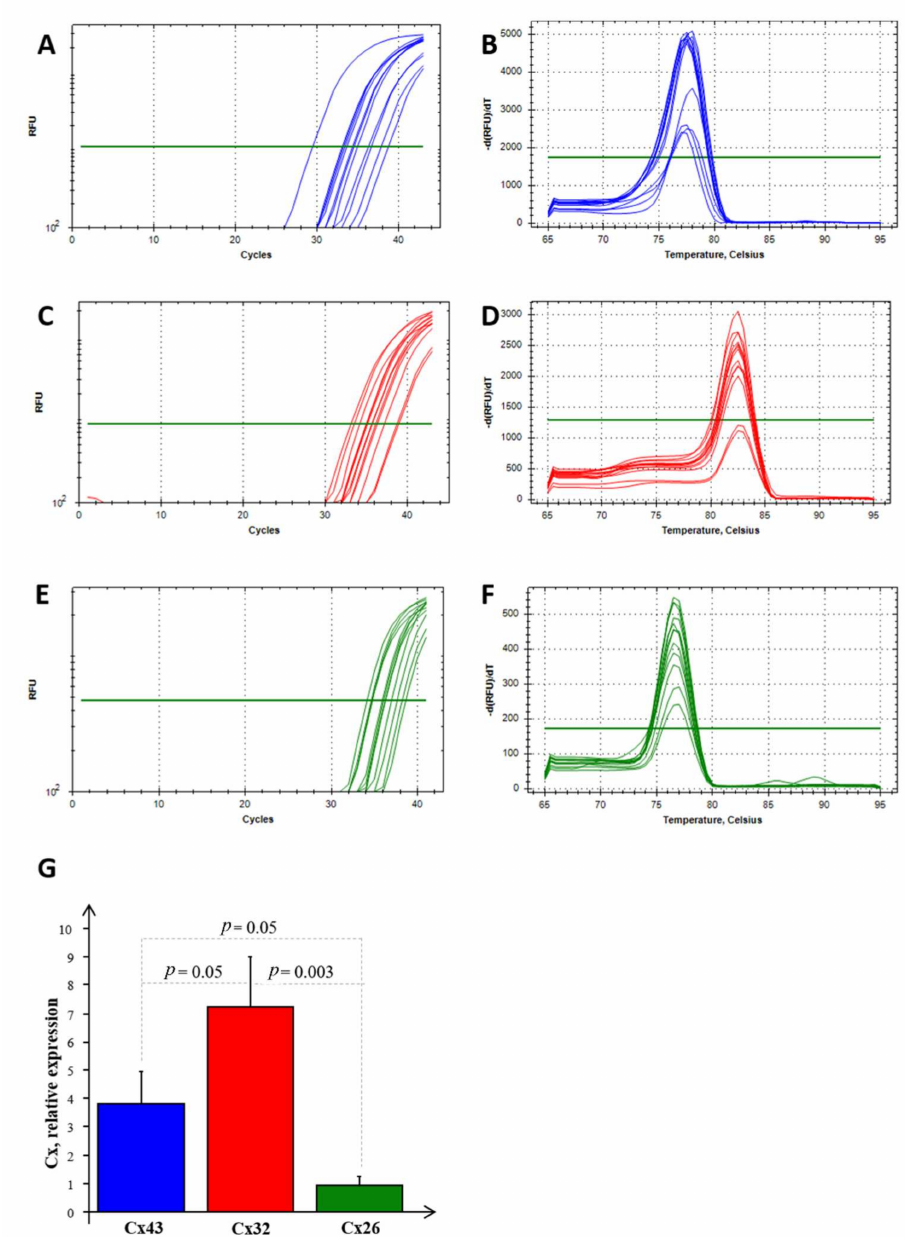
Figure 7. RT-PCR analysis for Cx26, Cx32, and Cx43 in NS-hLSGBs. Example of the threshold cycle (Ct), relative amplification curves, and Melting peak (the negative first derivative of the change in the fluorescence plotted as a function of temperature) for: Cx43 (blue) ( A , B ), Cx32 (red) ( C , D ), and Cx26 (green) ( E , F ); relative expression of Cxs in NS-hLSGB; data are expressed as means ± SEM ( G